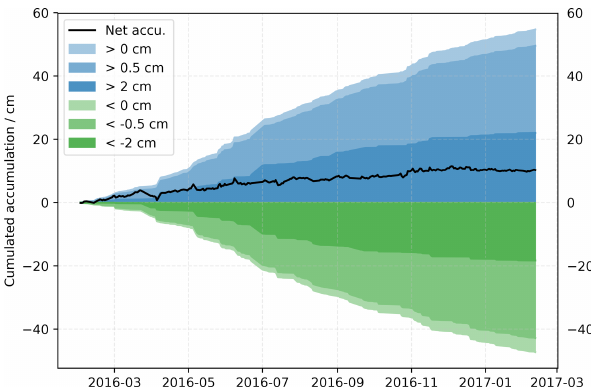
Figure 6. Cumulative spatially averaged amount of snow accumu- lated (blue > 0) and eroded (green < 0) in every pixel during the period February 2016–February 2017 (period 2a). Only events with accumulation over the threshold 0.5 and 2cm and erosion below the thresholds − 0 . 5 and − 2cm are taken into account for the lighter blue and green curves. Cumulative net accumulation is shown in black.